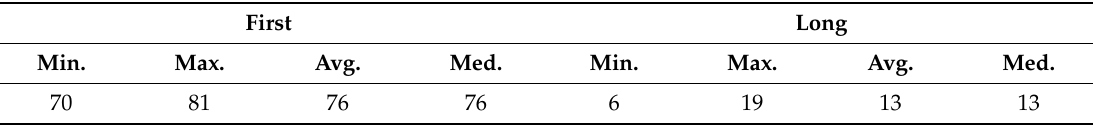
Table 4. First and long precedencies by factors.